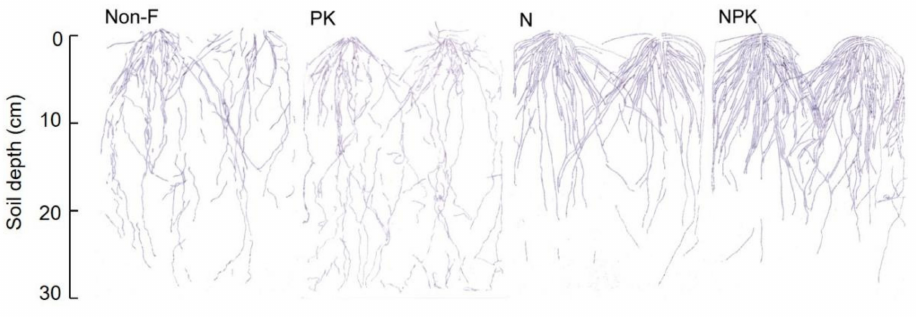
Figure 3. The images of rice root grown in rhizo-box at 42 d after transplanting at the 0–30 cm soil